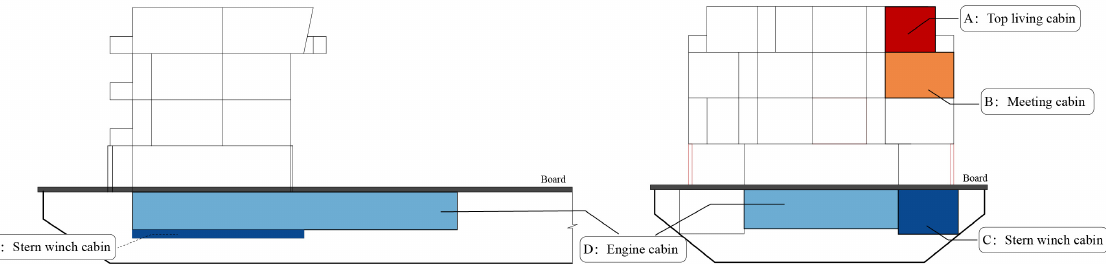
Figure 3. Cabin profile map of ship.